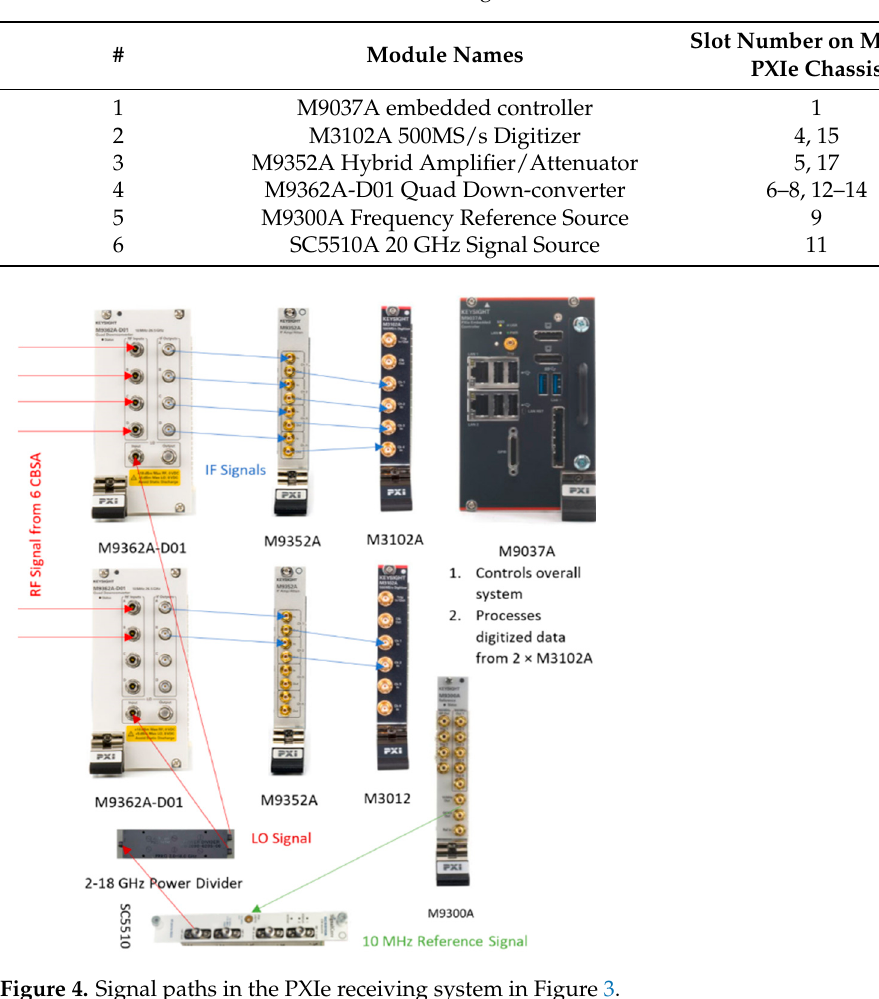
Table 2. PXIe modules used in the microwave digital receiver.